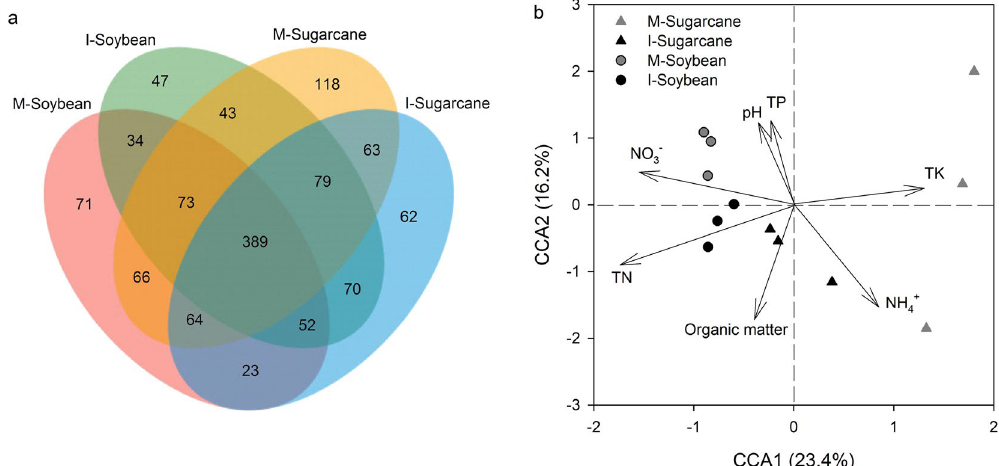
Figure 3. ( a ) Venn diagram showing the shared fungal OTUs in all soil samples. M-Sugarcane, sugarcane monoculture; I-Sugarcane, intercropped sugarcane. M-Soybean, soybean monoculture; I-Soybean, intercropped soybean, and ( b ) Canonical correspondence analysis (CCA) considering the relative abundance of fungal at the operational taxonomic unit (OTU) level and SOC, total N, P and K, concentrations of NH 4 + and NO 3 − and pH.